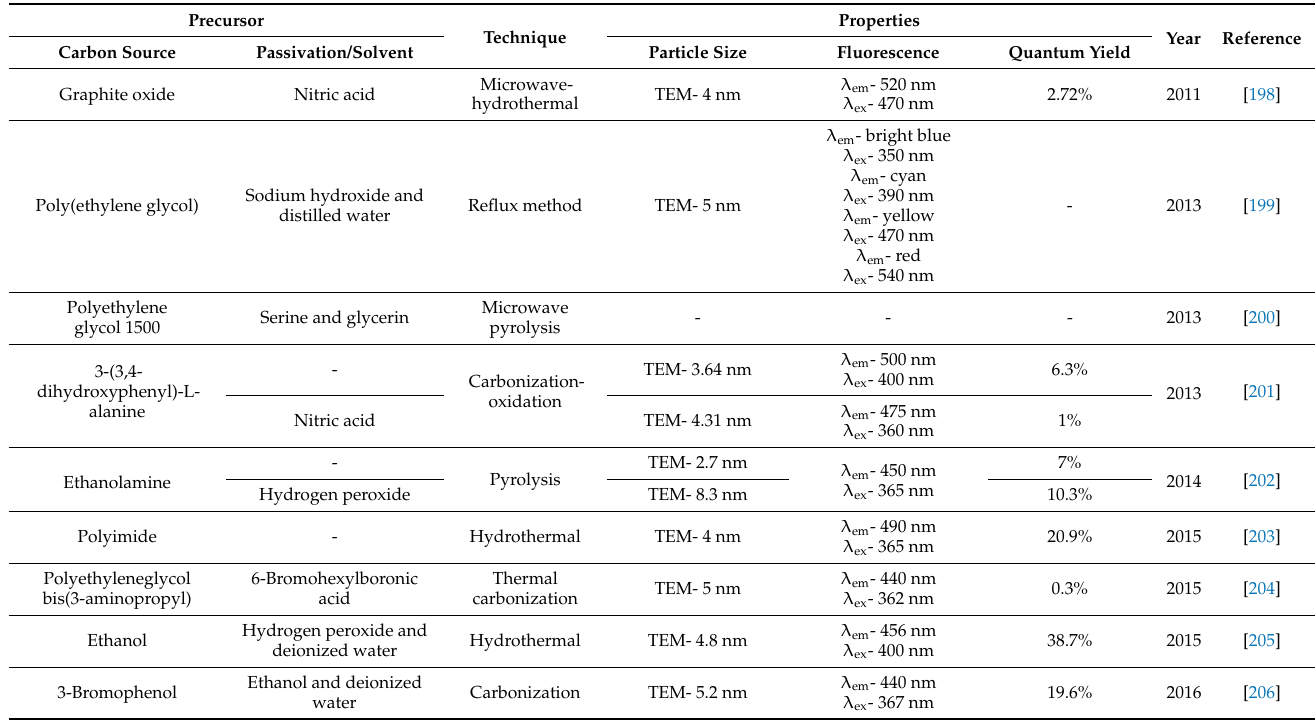
Table 9. Summary of the synthesis of CDs from non-acid